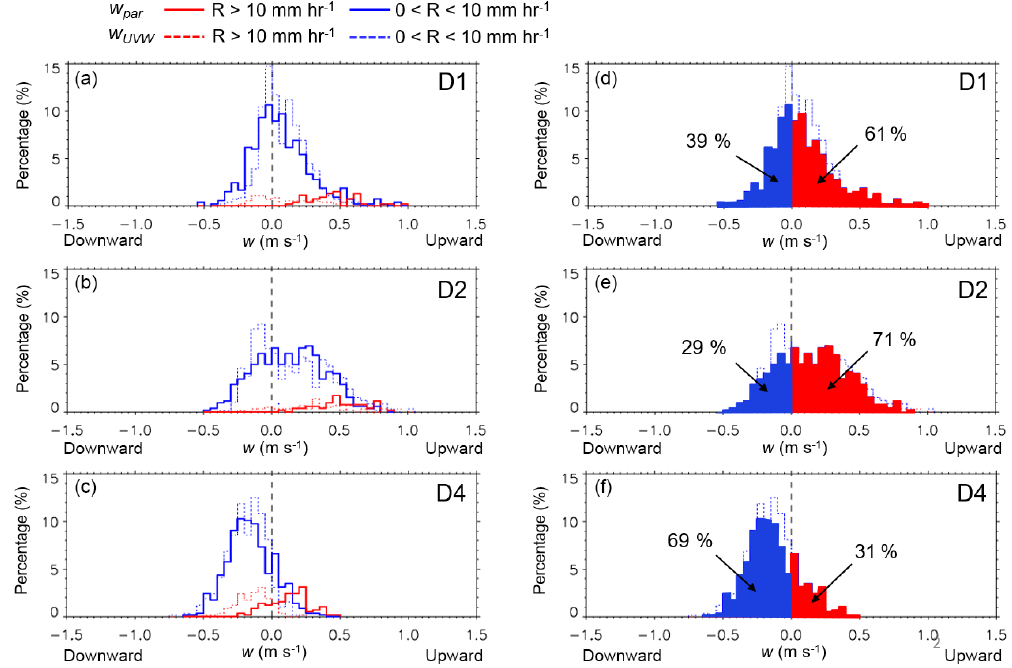
Figure 7. Frequency histograms of w (ms − 1 ) with regard to the two R groups (a, b, c) and those with percentages in the upward and downward w groups at the three sites (d, e, f)